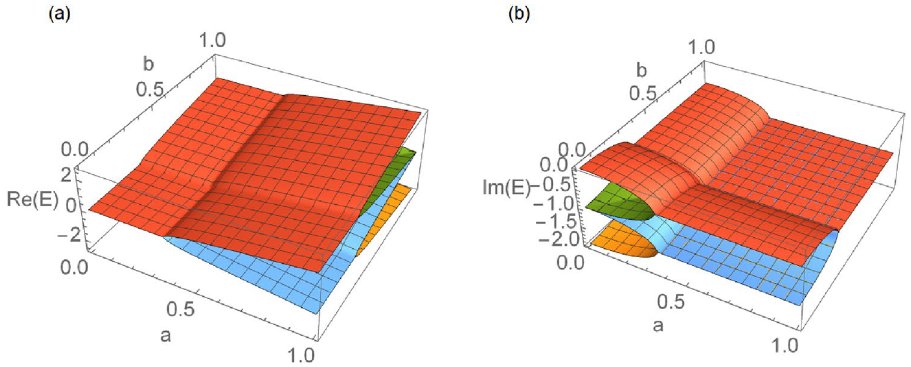
Figure 5. Eigenenergies of the two qubits non-Hermitian system. ( a ) The real parts of the eigenenergies. ( b ) The imaginary parts of the eigenenergies. Both the real and imaginary parts degenerate at a